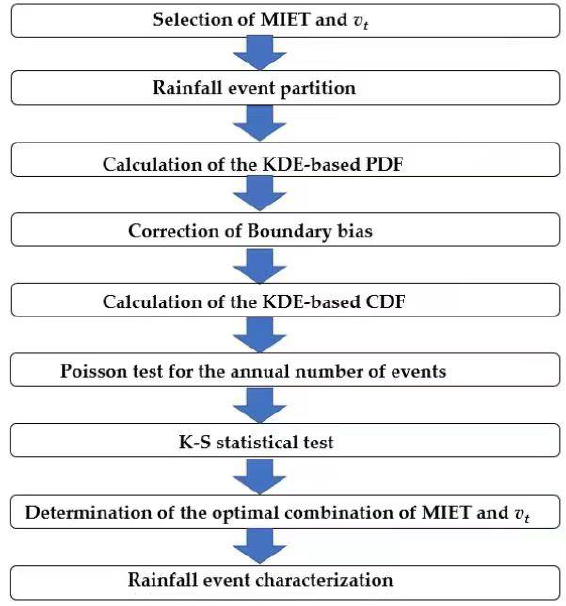
Figure 1. Flow chart of the methodology.